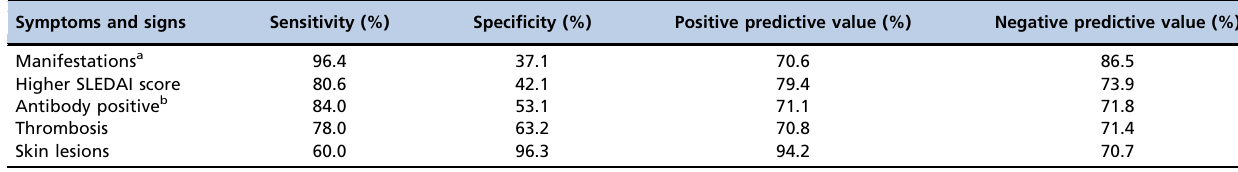
Table 1 - Sensitivity and specificity of the symptoms and signs of neuropsychiatric lupus erythematosus and analysis of their positive and negative predictive values. Symptoms and signs Sensitivity (%) Specificity (%) Positive predictive value (%) Negative predictive value (%) Manifestations